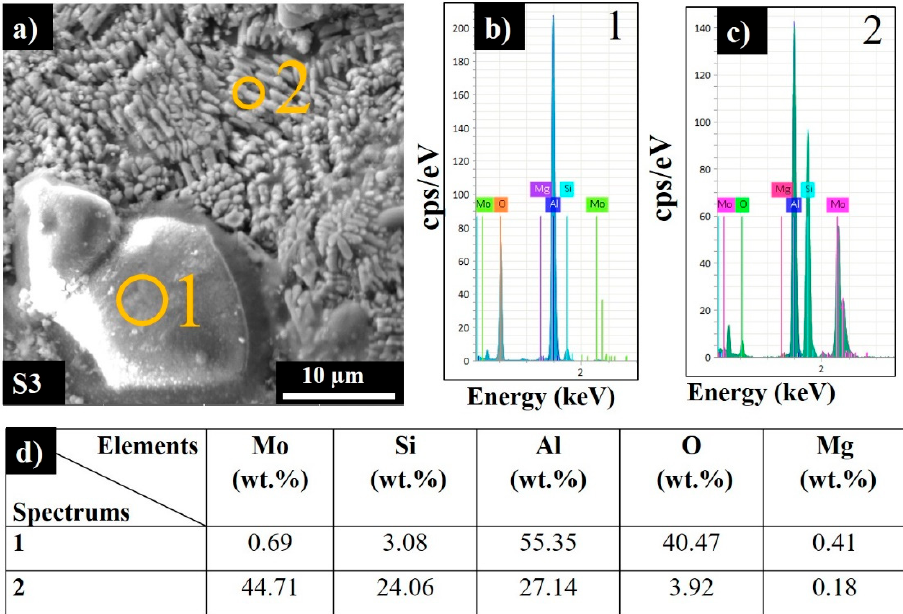
Figure 5. Side surface SEM image ( a ), EDS spectra ( b , c ), and corresponding elemental analysis results for sample S3 ( d ).